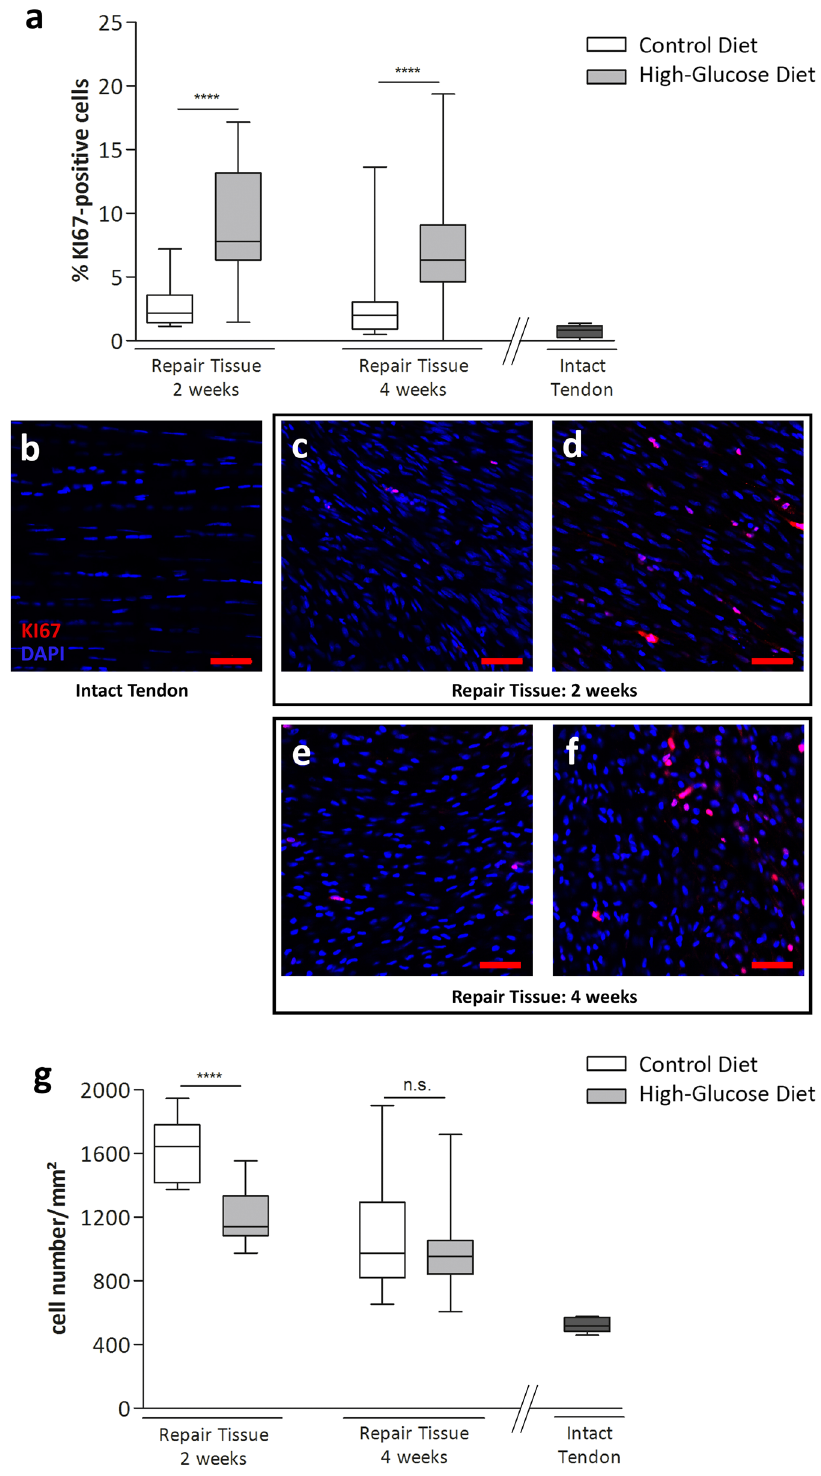
Figure 6. Quantification of cell proliferation by KI67 in tendon repair tissues. Compared to a control diet group, a high-glucose diet significantly increases the proportion of KI67-positive cells after 2 (p < 0.0001, n = 15 images of 3 animals/group) and 4 weeks (p < 0.0001, n = 30 images of 3 animals/group) ( a ) (Mann-Whitney test, two-tailed), whereas the total number of cells/area is significantly decreased in the high-glucose group compared to the control group after 2 weeks ( g ) (p < 0.0001, Mann-Whitney test, two-tailed). Representative images for intact control tendons ( b ) and tendon repair tissues 2 weeks post op: control group ( c ), high-glucose group ( d ) and 4 weeks post op: control group ( e ) and high-glucose group ( f ). Values for intact tendons are provided as a reference (n = 5 images of 3